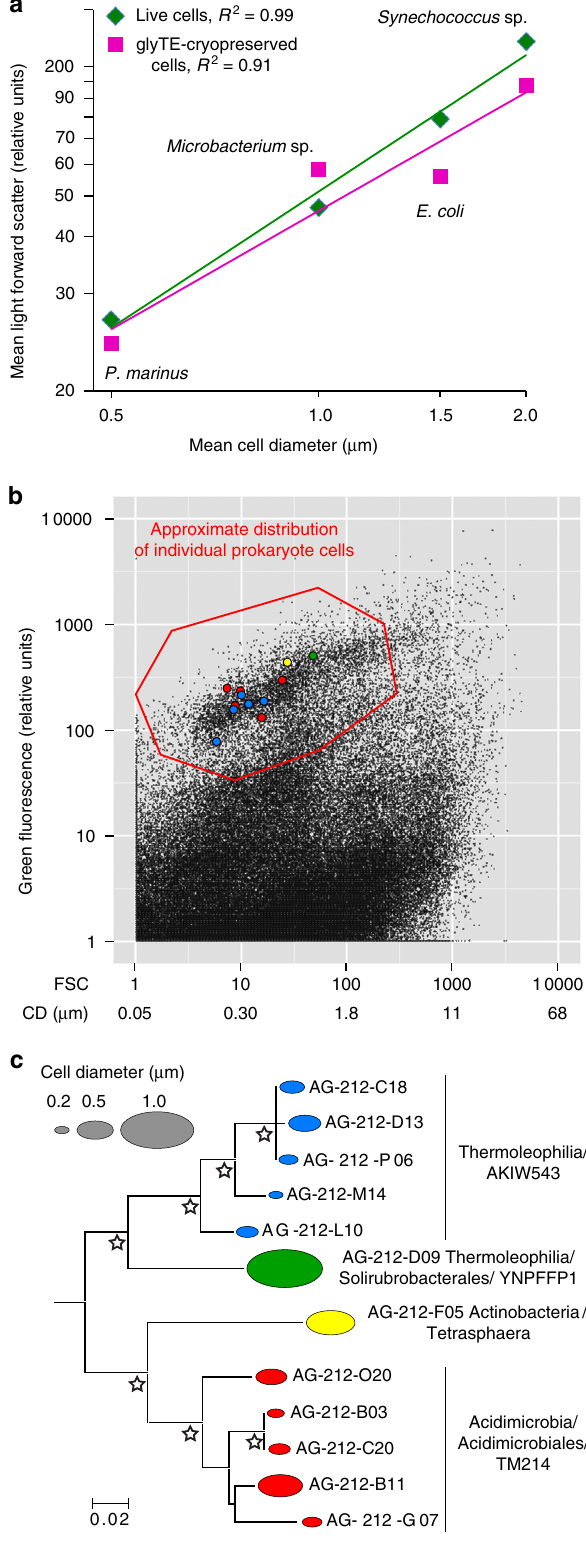
Fig. 5 Cell diameter equivalent determination of soil prokaryote cells using calibrated index FACS. a Log-linear regression between light forward scatter and cell diameter of the following laboratory cultures, with approximate cell diameters in parenthesis: P. marinus (0.5 µ m), Microbacterium sp. (1 µ m), E. coli (1.5 µ m), and Synechococcus sp. (2.0 µ m). b Light forward scatter and green fl uorescence of soil Actinobacteria cells stained with SYTO-9, in the context of other particles in the sample. CD = estimated cell diameter equivalents. Colors correspond to phylogenetic groups that are shown in c . c Estimated cell diameter equivalents and the SSU rRNA gene phylogeny of Actinobacteria SAGs. Stars indicate >